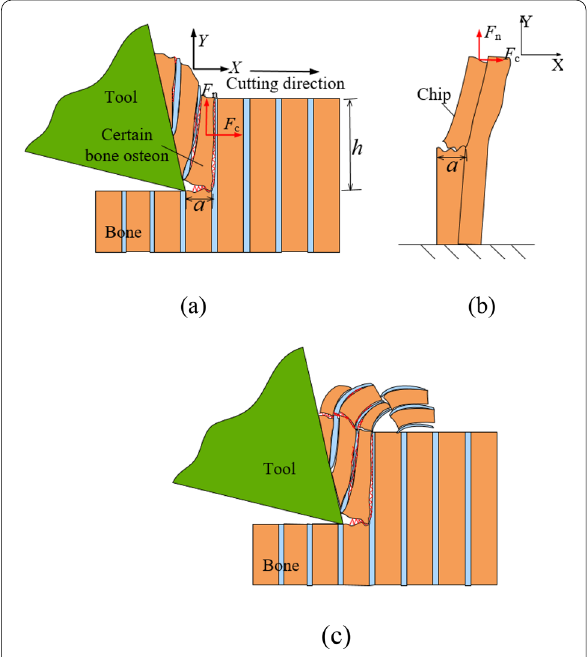
Figure 4 Mode #3: a Cutting model, b Forces applied on a bone osteon and c Predicted chip